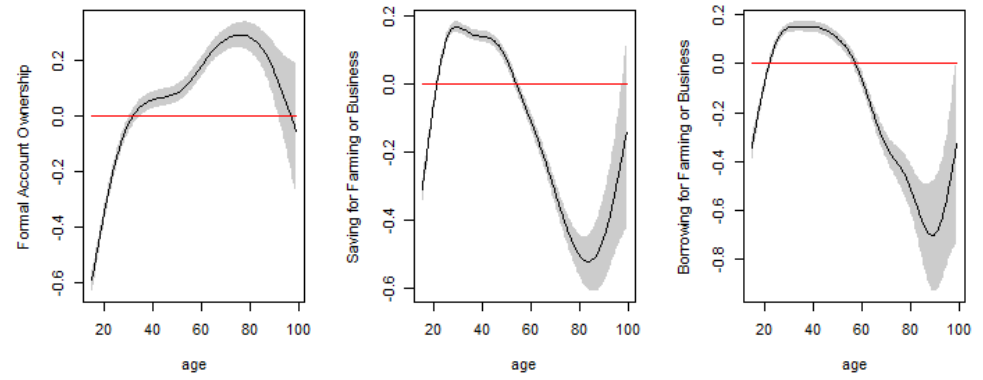
Figure 6. Smooth functions plots of the age variable in the semi-parametric specifications of the conditional probabilities of formal account ownership ( left panel), entrepreneurial saving ( middle panel), and entrepreneurial borrowing ( right panel).